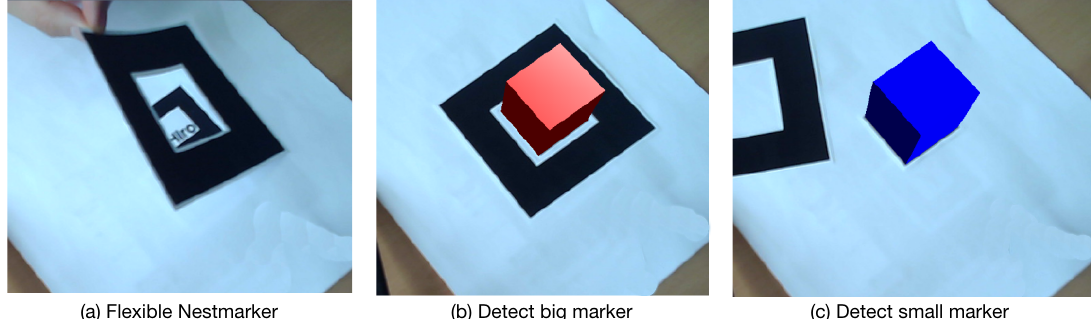
Figure 7. Flexible use of Nestmarker in narrow